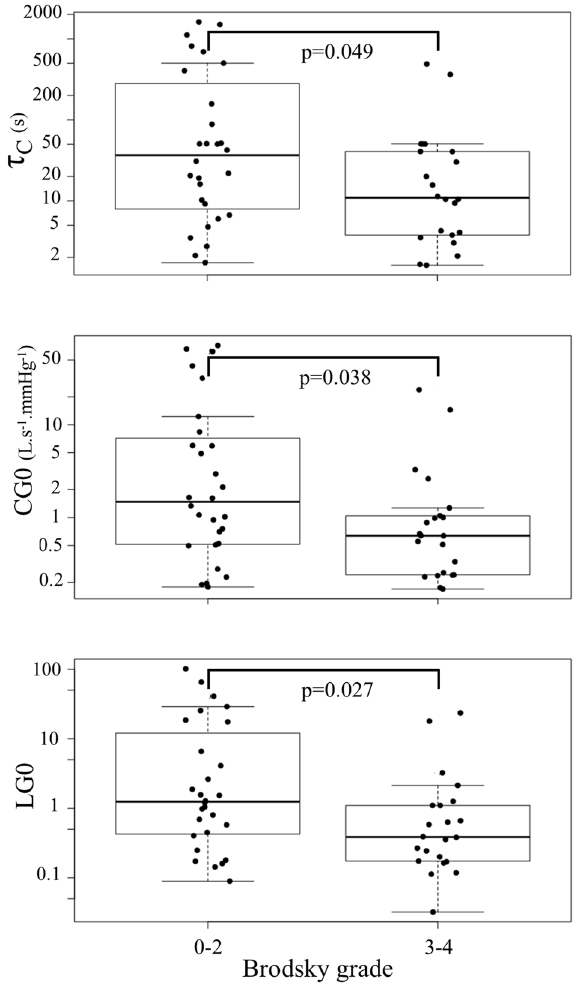
Figure 3. Controller time constant (τ c ), steady-state controller gain (CG0) and steady-state loop gain (LG0) in children with Brodsky grade 0 to 2 versus children with Brodsky grade 3 to 4 corresponding to oropharyngeal obstruction.